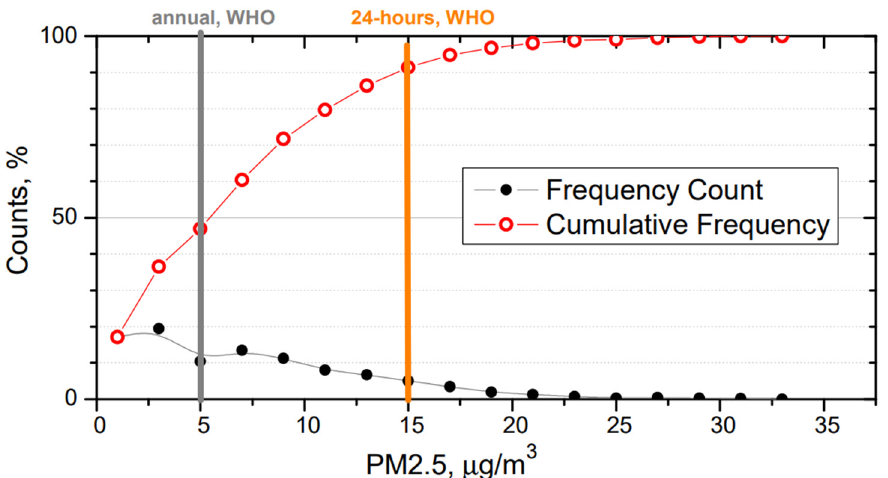
Figure 3. Frequency count and cumulative frequency of PM 2.5 in March 2022 measured at the urban background station in Vilnius along with WHO annual (bold grey line) and 24 h (bold orange line) limits for PM 2.5 .